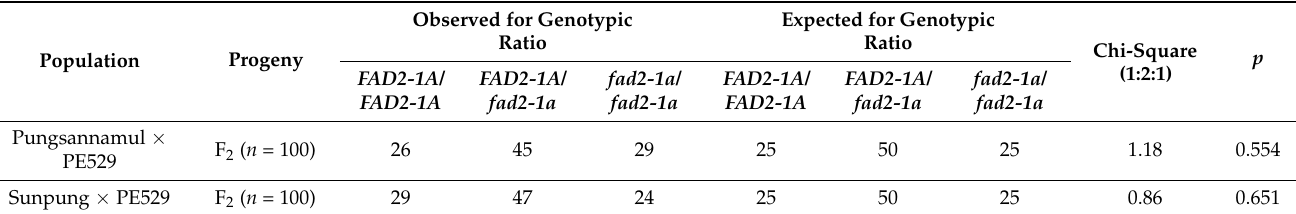
Table 1. Genotypic ratio of two F 2